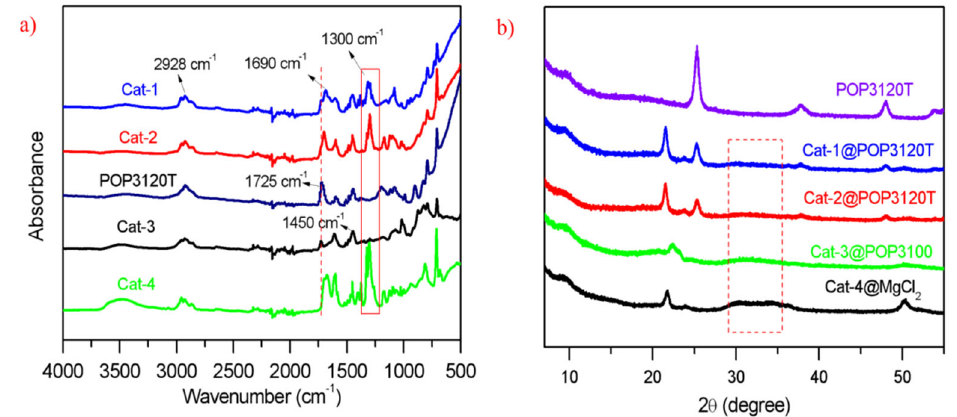
Figure 2. ( a ) FTIR results from the POP3120T and the prepared POP ‐ based and MgCl 2 ‐ based Z–N catalyst; ( b ) PXRD curves from POP3120T and the prepared catalysts containing MgCl 2 nanocrys ‐ tals. The peak around 21.7° can be assigned to the polyethylene crystal from the plastic protection film. No PE film used in